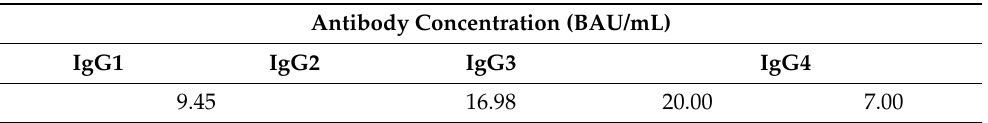
Table 6. Cut-off values for anti-S protein (RBD) antibodies calculated for each